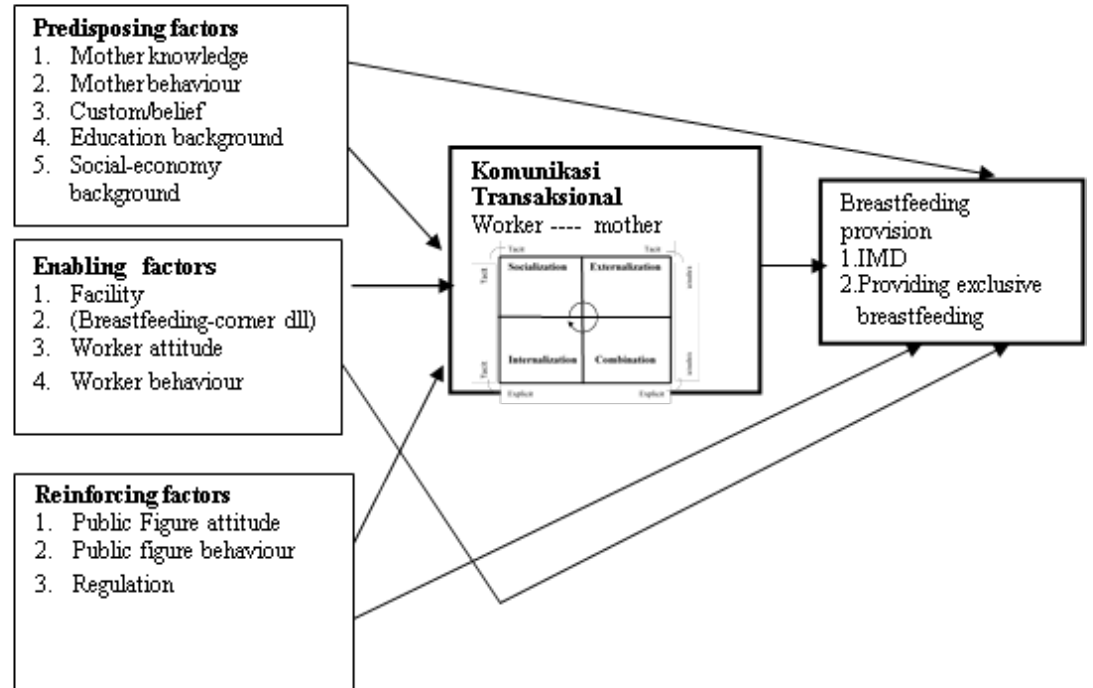
Figure 1. Model of Transactional Communication between Midwife and Patient based on Knowledge Management on Exclusive Breastfeeding Provision by Postpartum